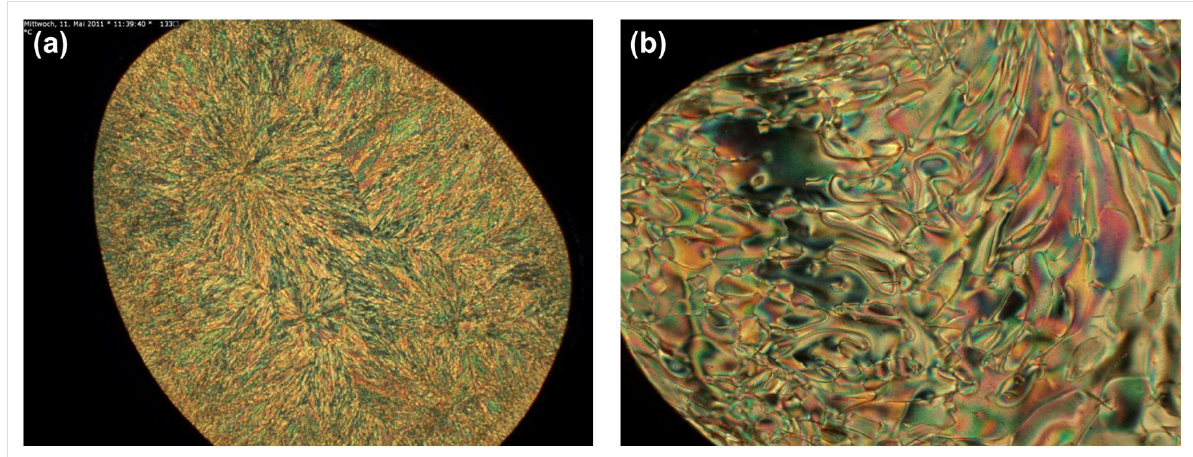
Figure 4: POM images of (a) 1a (20×, 133 °C, upon cooling); (b) 1d (20×, 84 °C, upon heating).